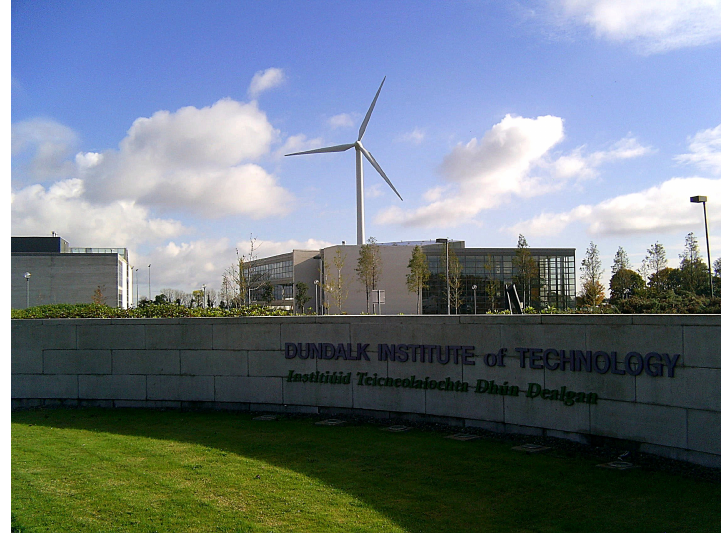
Figure 1. Vestas V52 wind turbine at